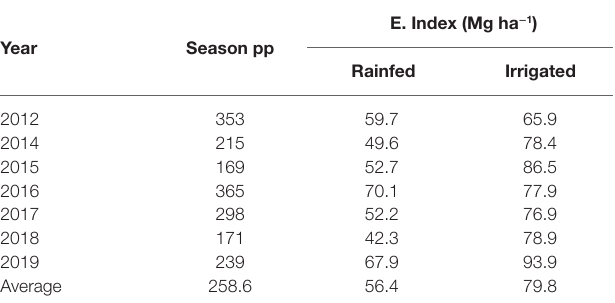
TABLE 4 | Environmental index (average yield of seven varieties) per year for irrigated and rainfed conditions.